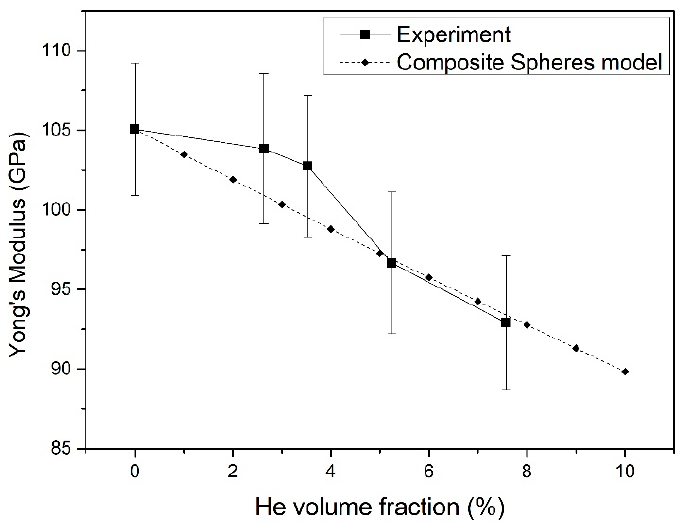
Figure 5. relationship of Young’s modulus of Er films with respect to the He volume fraction. Figure 5. Relationship of Young’s modulus of Er films with respect to the He volume